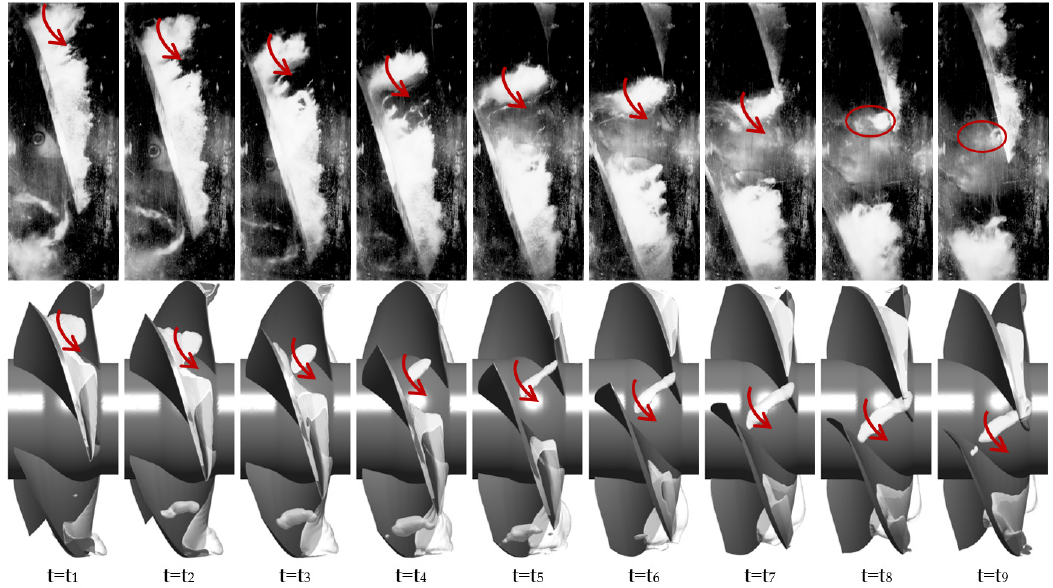
Figure 9. Evolution of cavitation patterns ( top picture: experiment, bottom picture: numerical simulation).